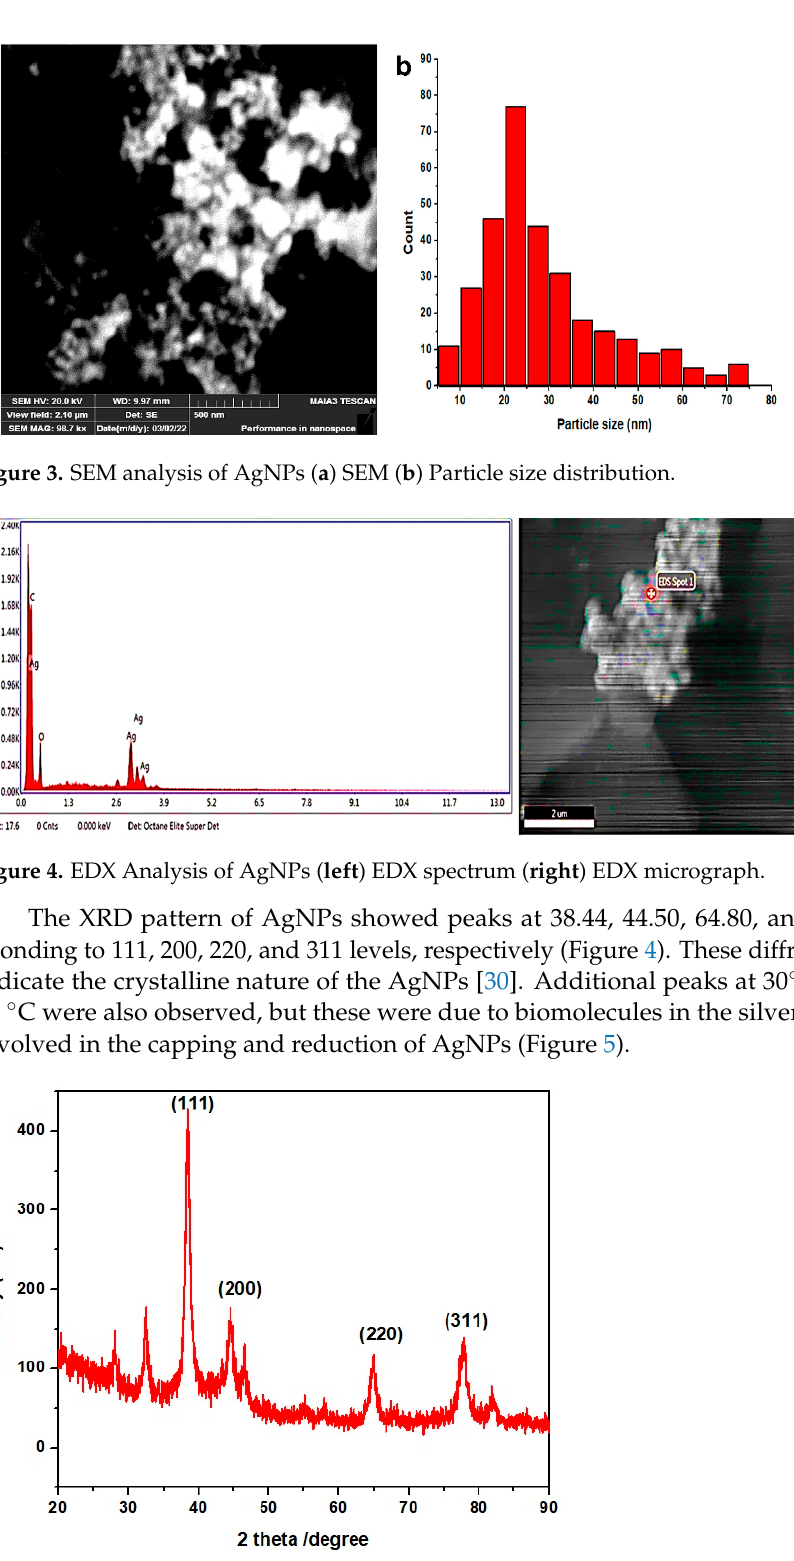
Figure 5. XRD Analysis of AgNPs .